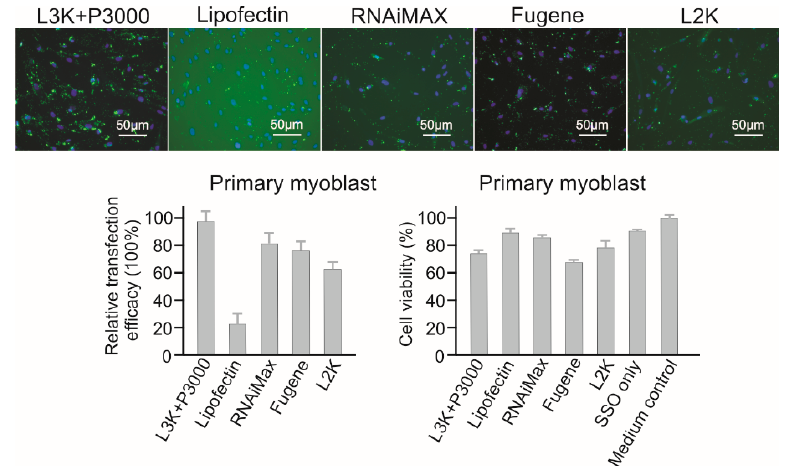
Figure 8. In vitro transfection efficiency and cytotoxicity of different transfection reagents in Primary myoblast cells. L3K: Lipofectamine 3000, L2K: Lipofectamine 2000.